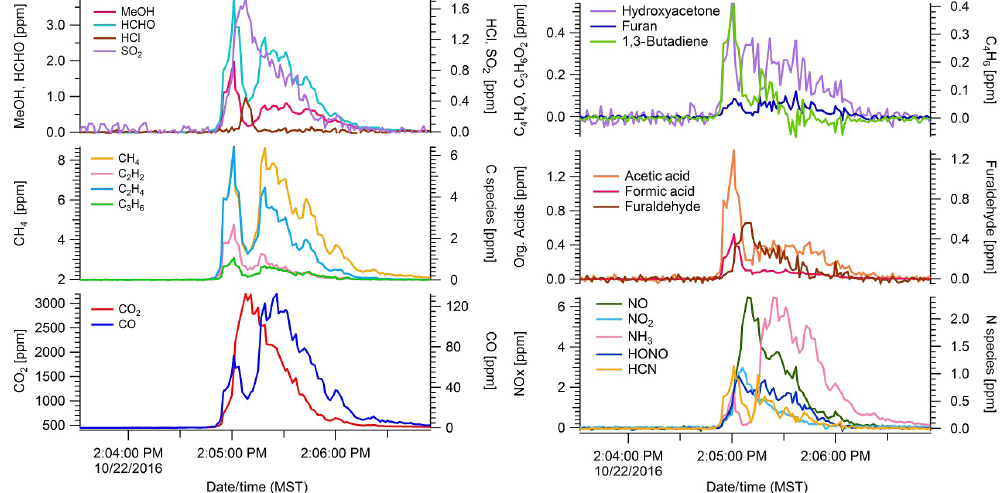
Figure 1. Excess mixing ratios of 21 trace gases vs. time for a complete juniper canopy stack burn (no. 75) as measured using the OP-FTIR. CO 2 denotes flaming; CO denotes smoldering. 1,3-Butadiene is shown as an example of lower signal-to-noise data but retained since there is no evidence of